Question: Describe this figure in one sentence.
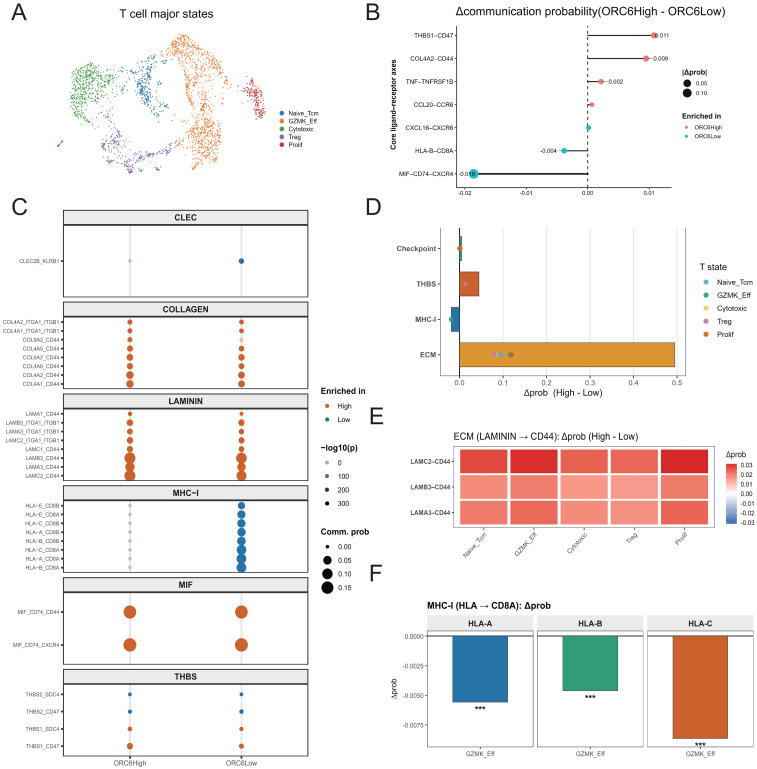
Answer: Transcript-based CellChat inference suggests hypothesis-generating epithelial–T-cell interaction patterns associated with the ORC6-high malignant epithelial state. (A) Overview of major T-cell states. (B) Representative ligand-receptor pairs showing differential communication strength between ORC6-high and ORC6-low conditions. (C) Pathway-level summary of differential interaction pairs across T-cell states. (D) Axis-level summary of the direction and magnitude of communication changes. (E) Δprob heatmap for a representative ECM-CD44 interaction axis across T-cell states. (F) Representative MHC-I-related interaction view (HLA-CD8). Δprob = prob(ORC6High) - prob(ORC6Low); Δprob > 0 indicates relative enrichment in ORC6-high, whereas Δprob< 0 indicates relative enrichment in ORC6-low. ***P < 0.001.